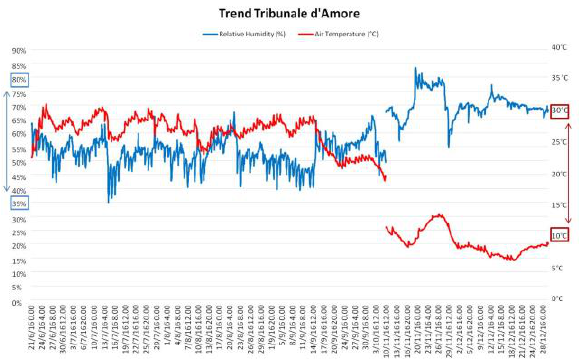
Figure 7. Air Temperature and Relative Humidity Trends, Room (3) Tribunale D’Amore